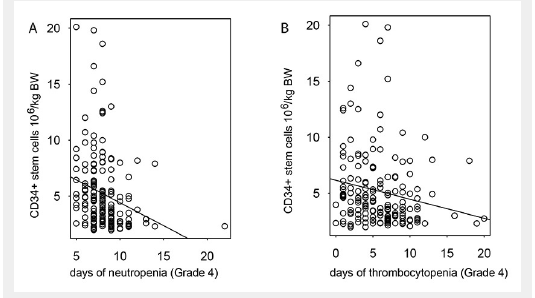
Correlation of the number of reinfused CD34+ stem cells with the length of neutropenias (r = –0.25, fig. A) and thrombocytopenias (r = –0.18, fig. B) after ASCT.